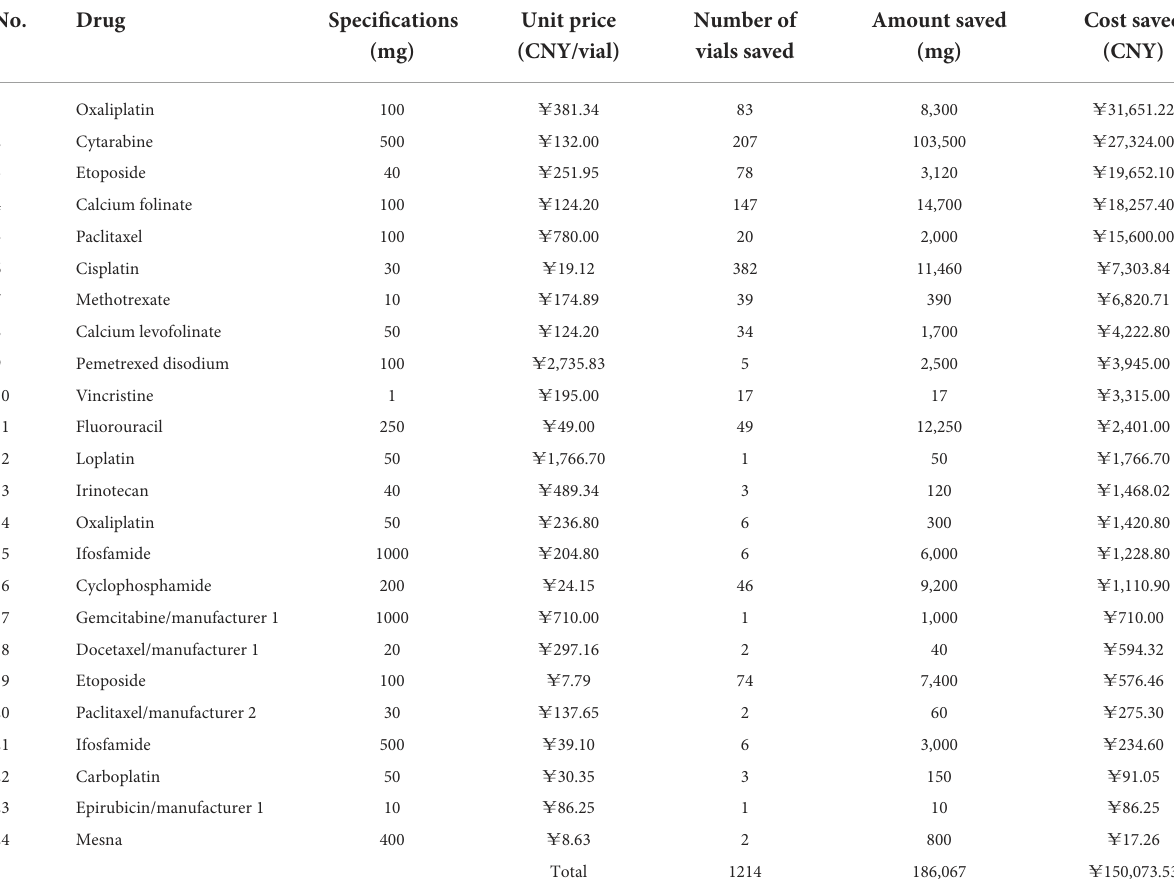
TABLE 4 Wasted drugs and costs saved through vial-sharing